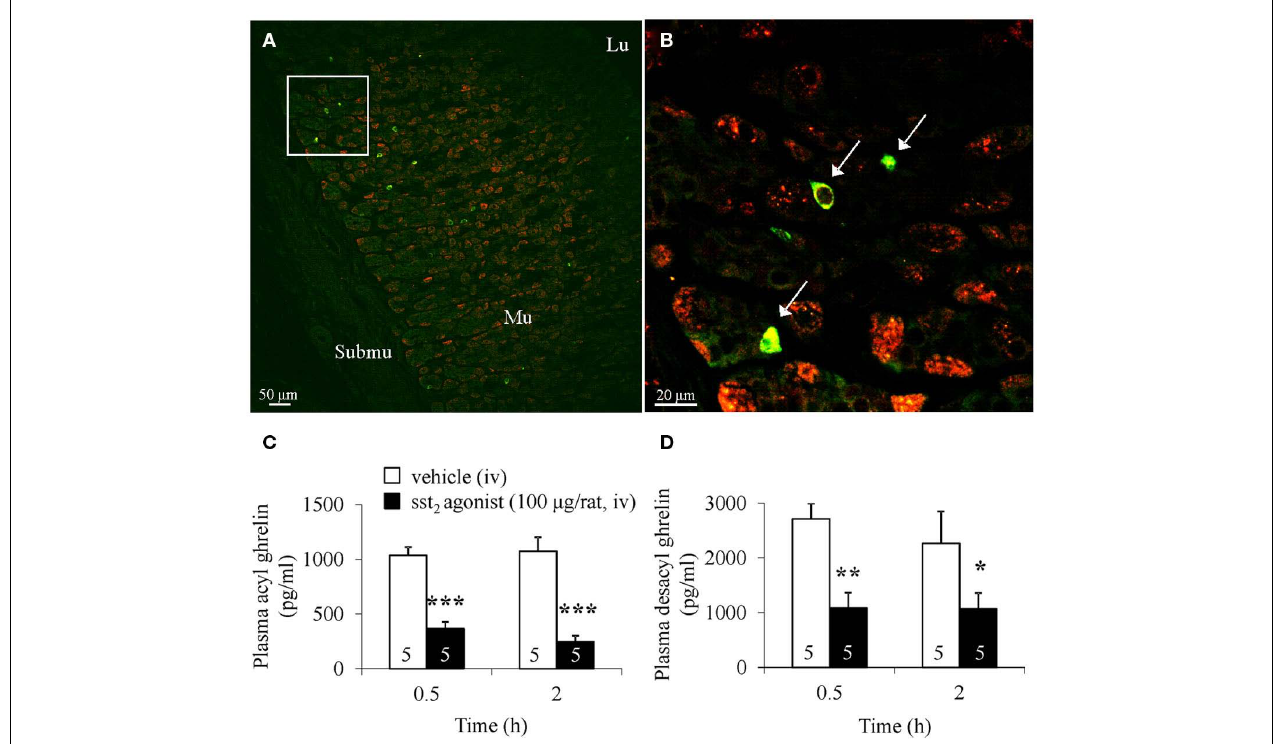
FIGURE 2 | Somatostatin could act directly on gastric X/A-like cells by interaction with the somatostatin receptor subtype 2 (sst 2 ) localized on these cells. (A,B) Ghrelin-positive X/A-like cells in the gastric oxyntic mucosa express the sst 2a receptor in naive rats. Paraffin-embedded gastric corpus sections of ad libitum fed rats were processed for immunofluorescent double labeling. Confocal microscopy shows the localization of sst 2a -immunopositive cells throughout the gastric oxyntic mucosa [ (A) , red], whereas ghrelin-positive cells are localized mostly in the middle and the lower part of the glands [ (A) , green].The higher magnification (B) shows that ghrelin-positive cells express the sst 2a receptor (arrow). Lu, lumen; Mu, mucosa; Submu, submucosa. (C,D) The